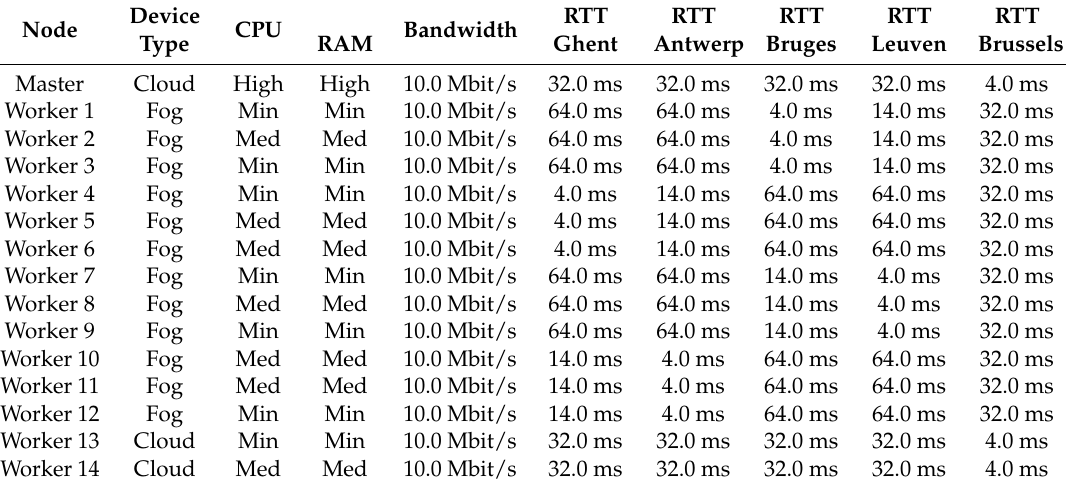
Table 1. The implemented node labels in the Kubernetes